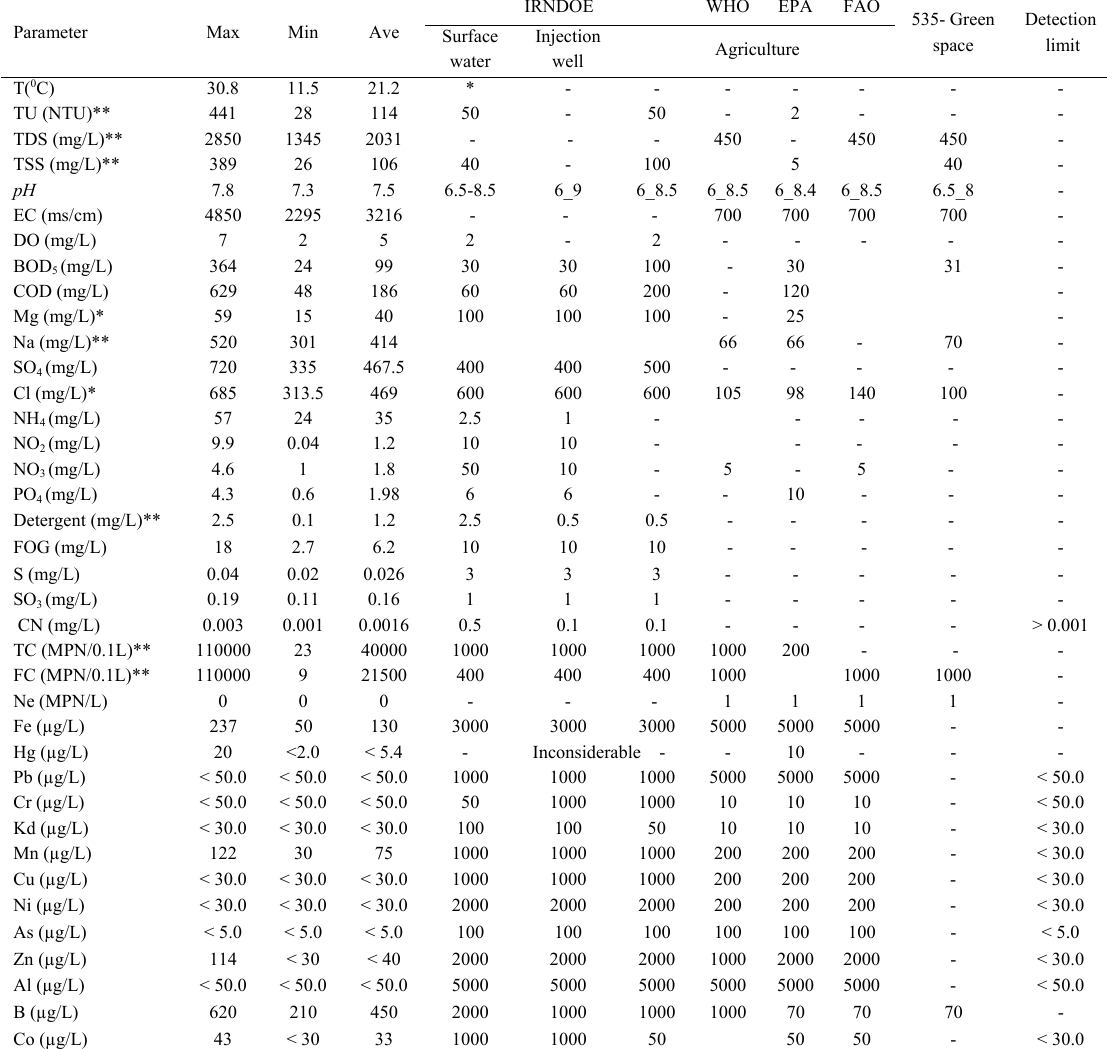
Table 1: Measured and analized physico-chemical parameters in the treated wastewater from Qom